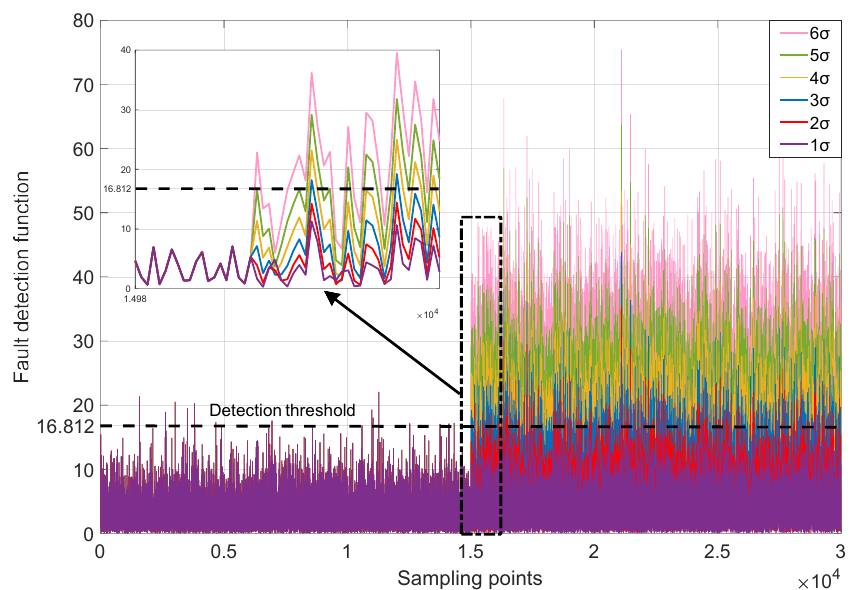
Figure 3. The gyro measurement signals with various constant drift faults.